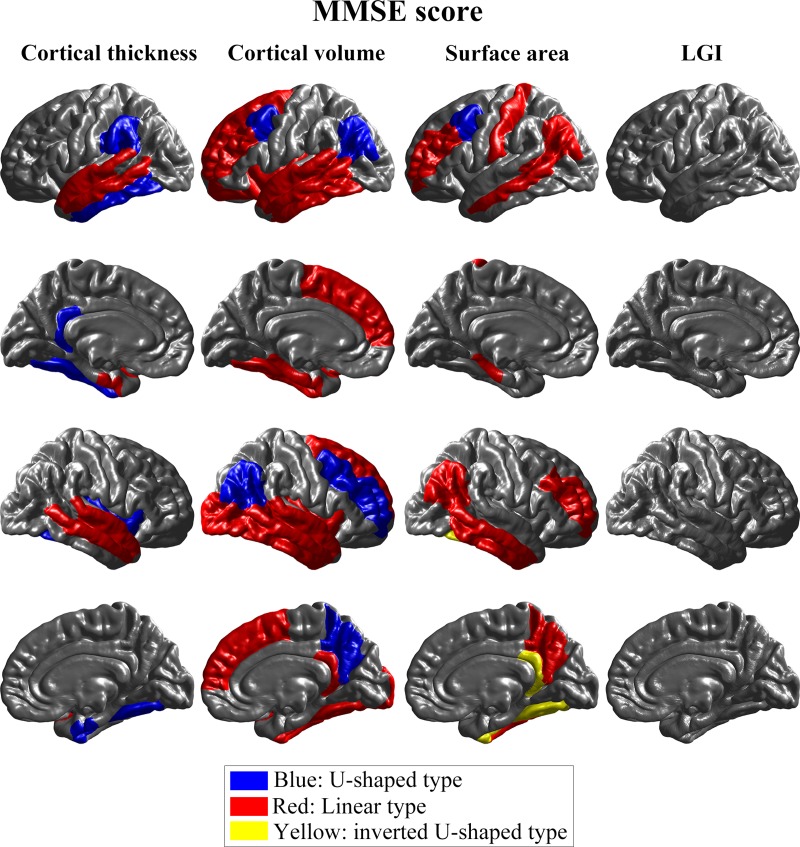
Comparison of descending graph types between cortical volume, thickness, surface area, and LGI in MMSE score.The first and second rows show the left hemisphere from a lateral and medial view, respectively. Similarly, the third and fourth rows represent the right hemisphere from a lateral and medial view. The blue regions represent the U-shaped type and indicates sensitivity to cognitive impairment in the early stages of Alzheimer disease. The red regions represent the linear type, showing that the ROI may be continuously damaged as the disease progresses. The yellow regions represent the inverted U-shaped type, meaning that cognitive decline is most sensitive at the last stages. LGI local gyrification index.